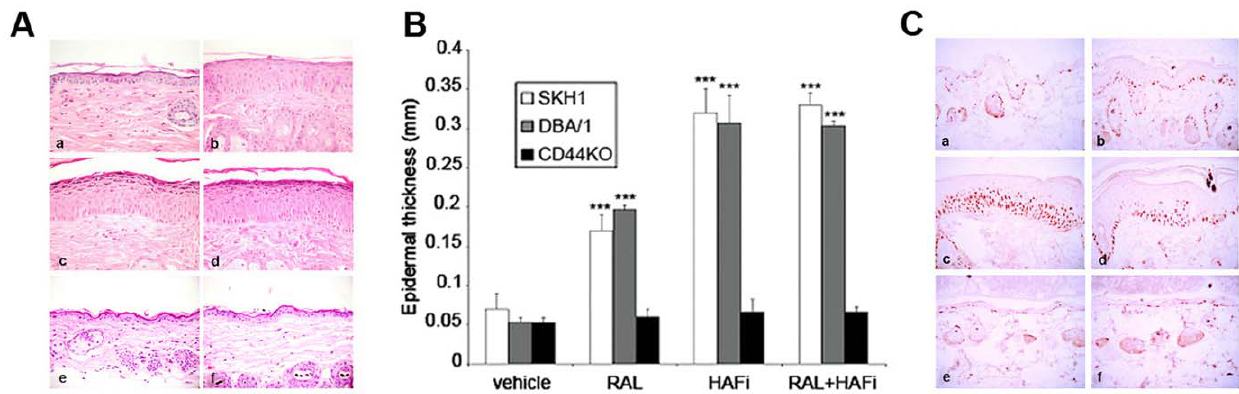
Figure 2. The effect of RAL and HAFi invivo . A. The effect of RAL and HAFi in vivo on mouse skin. Histological sections of vehicle- (a), RAL- (b), HAFi- (c) or RAL- and HAFi- (d) treated DBA/1 and vehicle (e) or RAL- (f) treated CD44-/- mouse dorsal skin. Note the significant epidermal hyperplasia in DBA/1 but not in CD44-/- mice. B. Epidermal thickness in SKH1, DBA/1 and CD44-/- mouse dorsal skin measured with an ocular micrometer. Ten measurements were performed per mouse and the average value was calculated. The results are presented as the mean epidermal thickness 6 SEM of six animals per group. ***p , 0.001 versus vehicle (student’s t test). C. Ki67 staining of vehicle- (a), RAL- (b), HAFi- (c) or RAL- and HAFi- (d) treated DBA/1 and vehicle (e) or RAL- (f) treated CD44-/- mouse dorsal skin.